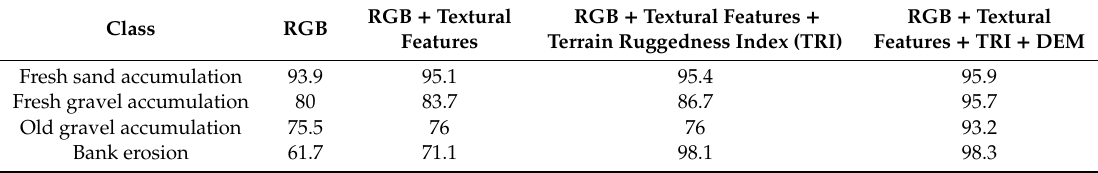
Table 6. Classification accuracy for di ff erent classes